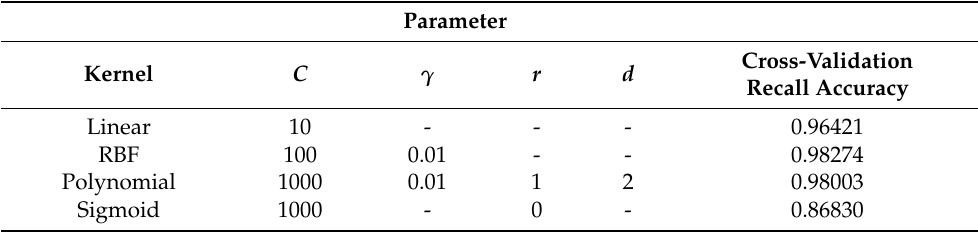
Table 1. SVM kernel parameter